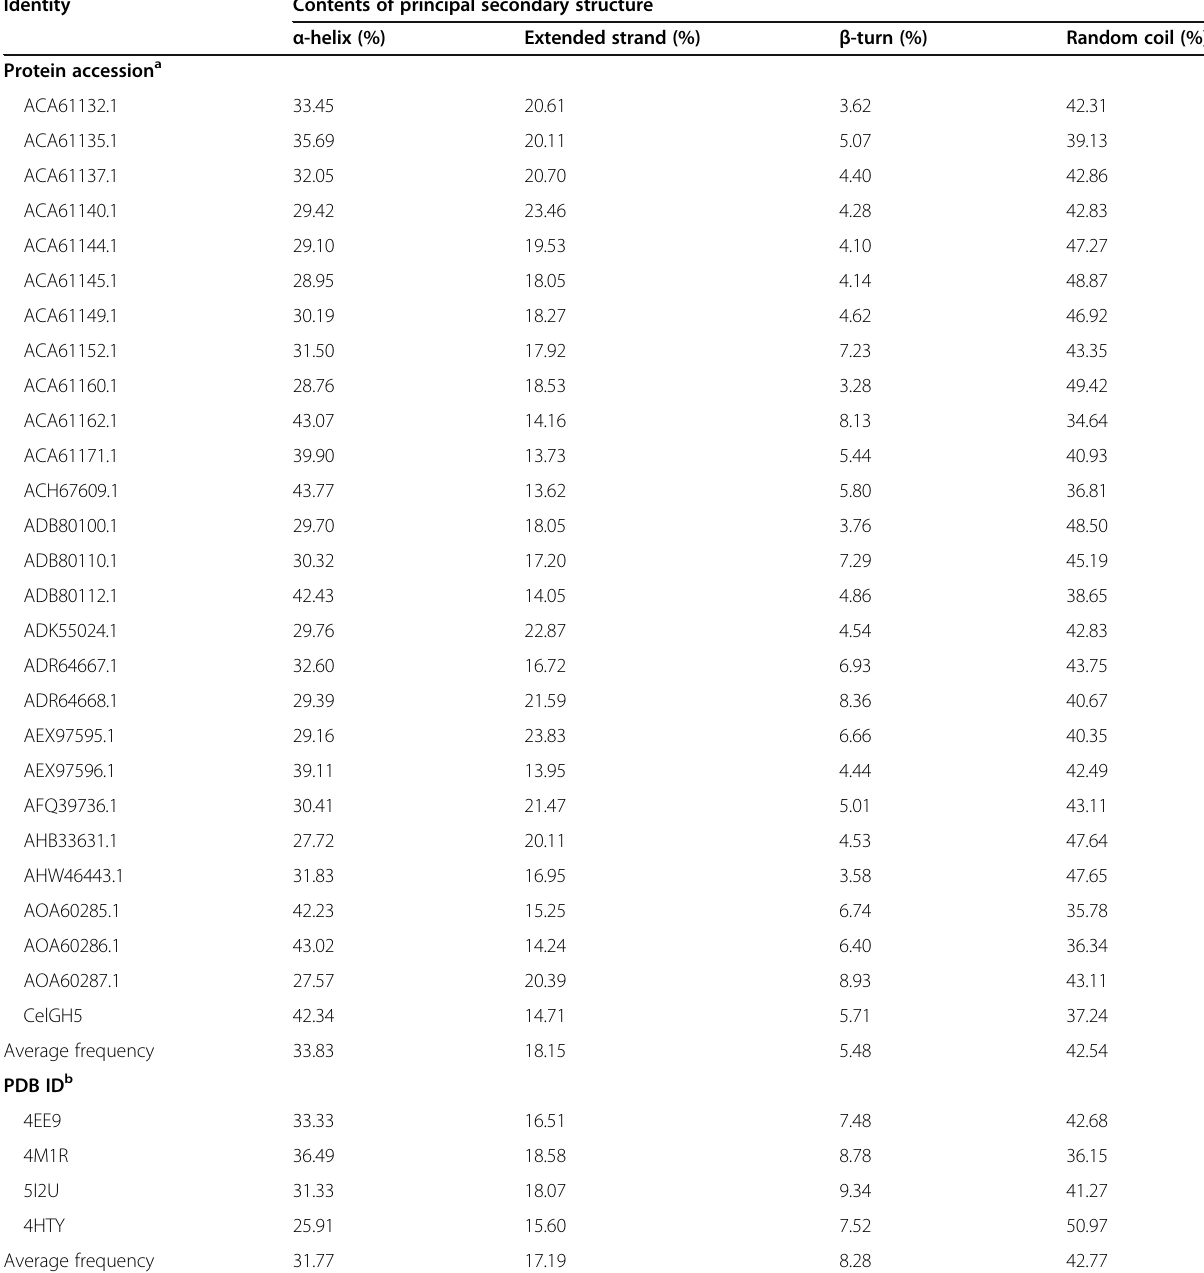
Table 4 Secondary structure among different sequences of GH5-cellulase family from uncultured microorganisms